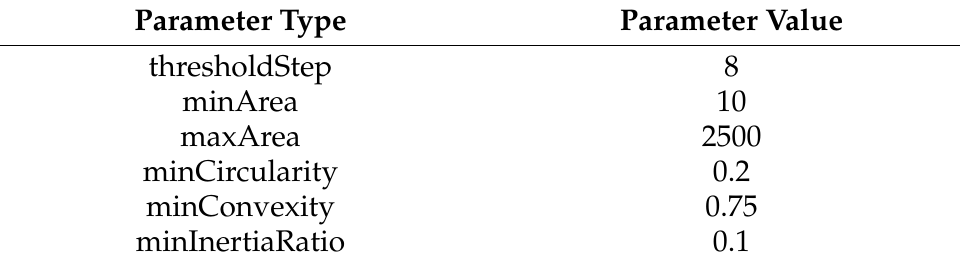
Table 2. SimpleBlobDetector parameter